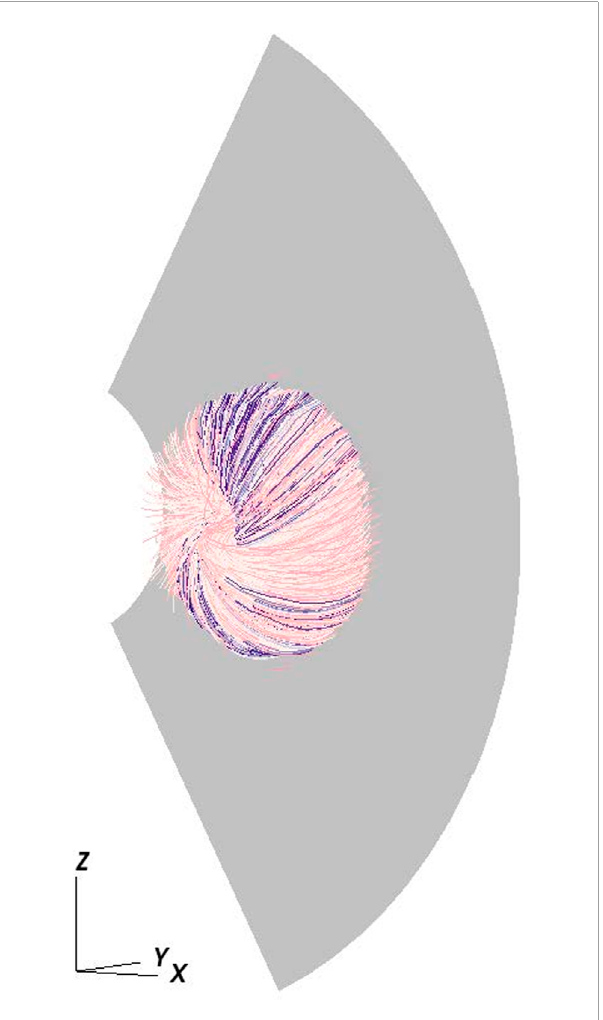
FIGURE 11 Magnetic field lines depicting the structure of the LFFS CME model with a 90.0° tilt (Verbeke et al.,